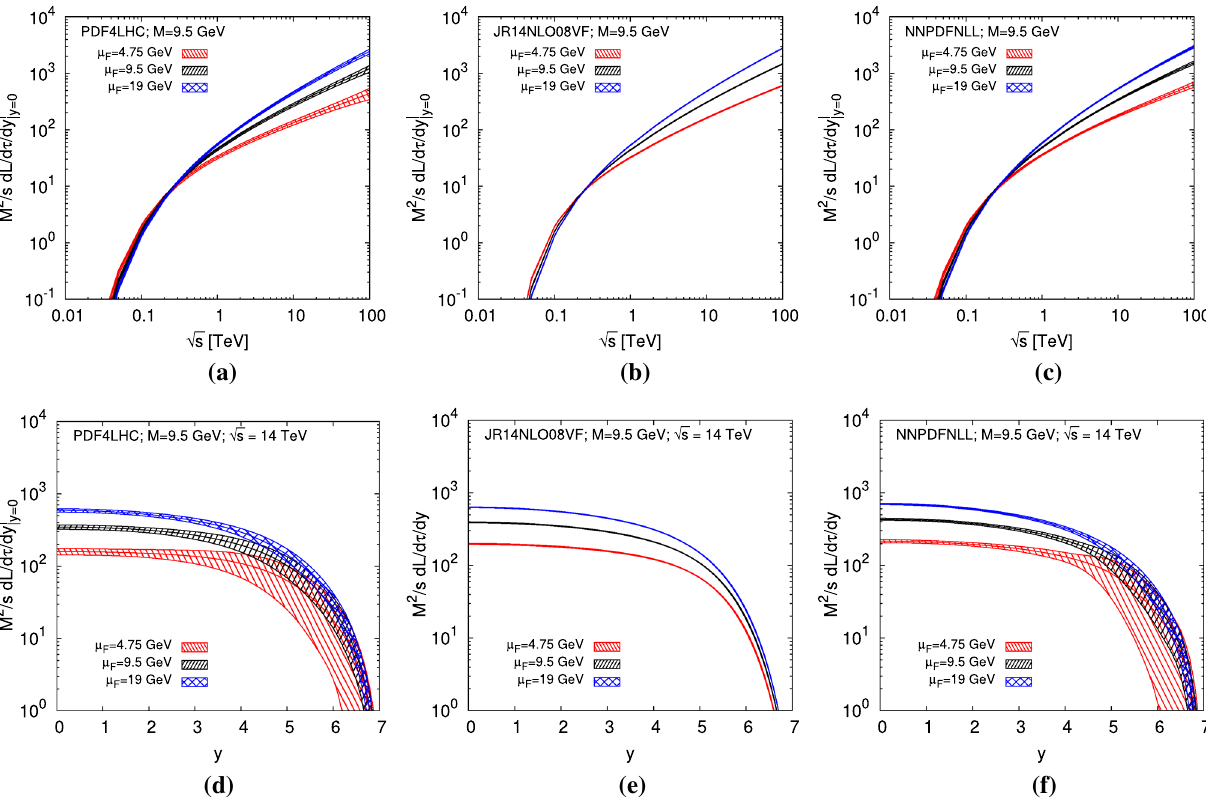
√ Fig. 6 τ 0 ∂ L ∂τ∂ s and at y = 0 (top) and τ 0 ∂ L ∂τ∂ as a function of energy y PDF4LHC15_nlo_30 (left), JR14NLO08VF (middle) and NNPDF31sx_nlonllx_as_0118 (right)) for 3 μ F values (0 . 5 M , M and 2 M